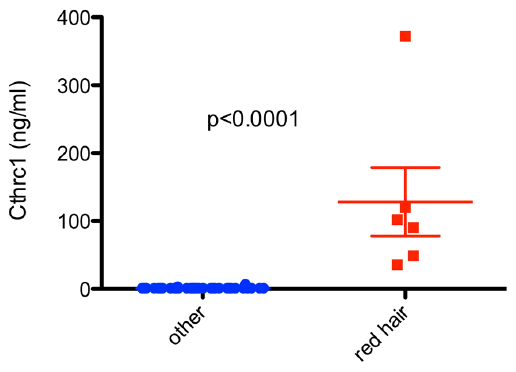
Figure 4. Cthrc1 plasma levels in healthy human subjects. Significantly higher Cthrc1 plasma levels were found in all subjects with red hair.